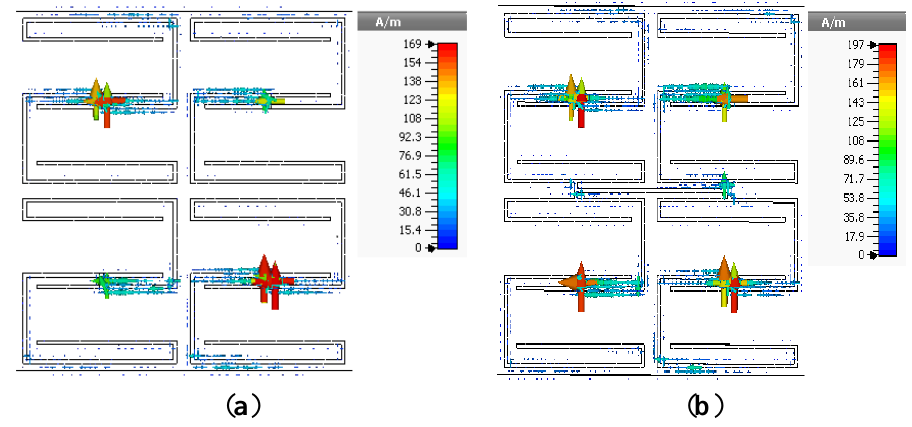
Figure 13. Surface current distributions of 2 × 2 array of unit cell D at 3.5 GHz: ( a ) open array and ( b ) interconnected array.